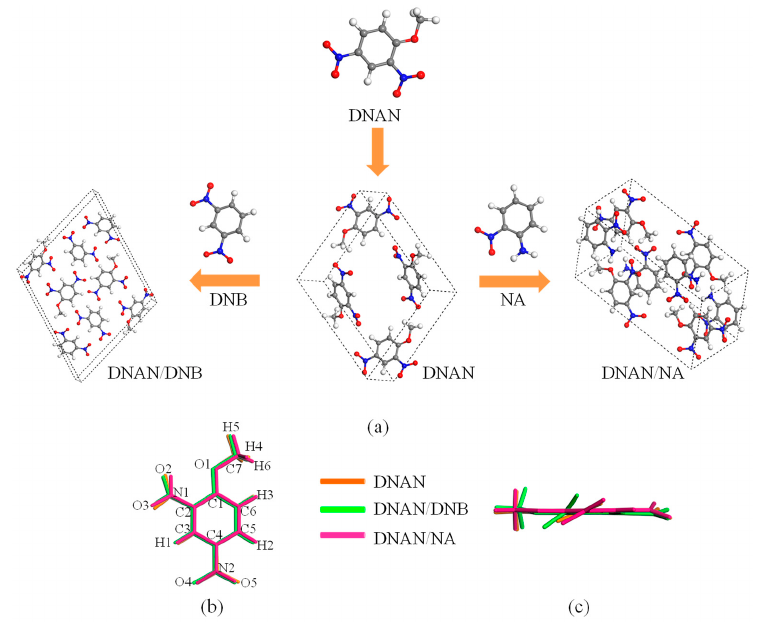
Figure 1. Crystal and molecular structure ( a ) of DNAN, DNB, NA, DNAN/DNB, and DNAN/NA. Orange, green, and pink represent the DNAN molecules originating from pure DNAN crystals, DNAN/DNB co-crystals, and DNAN/NA co-crystals, respectively. ( b ) and ( c ) are front and side views, respectively. Table 1. Calculated and experimental lattice parameters of the pure DNAN crystal and its cocrystals. DNAN DNAN/DNB